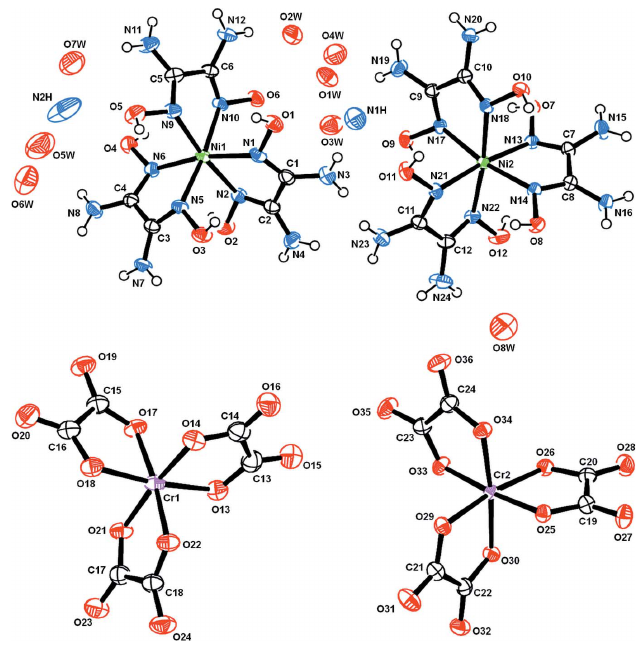
Figure 2 Aview along [100] of the crystal packing of ( I ), illustrating the orientation of the complex ions in an eclipsed configuration within each pillar as well as the channels between the pillars.